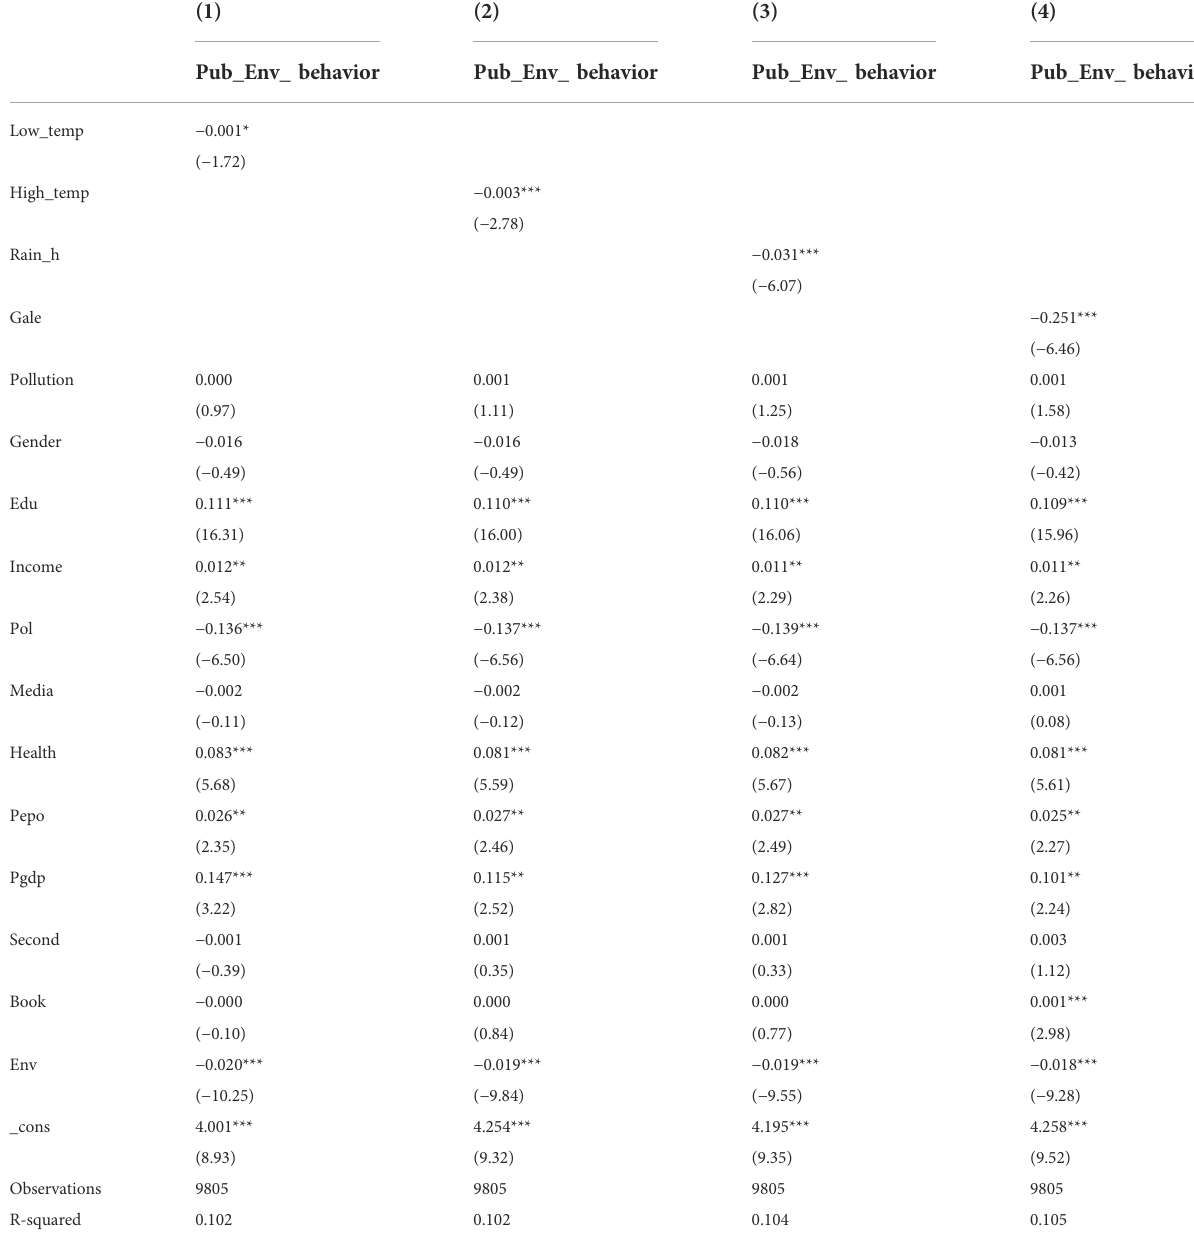
TABLE 6 Control of environmental pollution